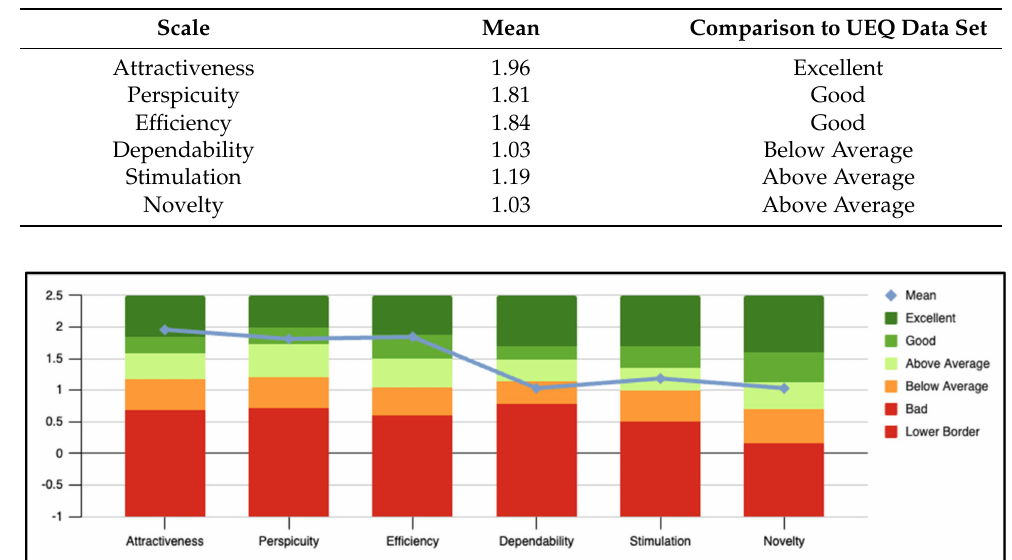
Table 2. ACUX-R mean values per scale compared to the UEQ dataset.